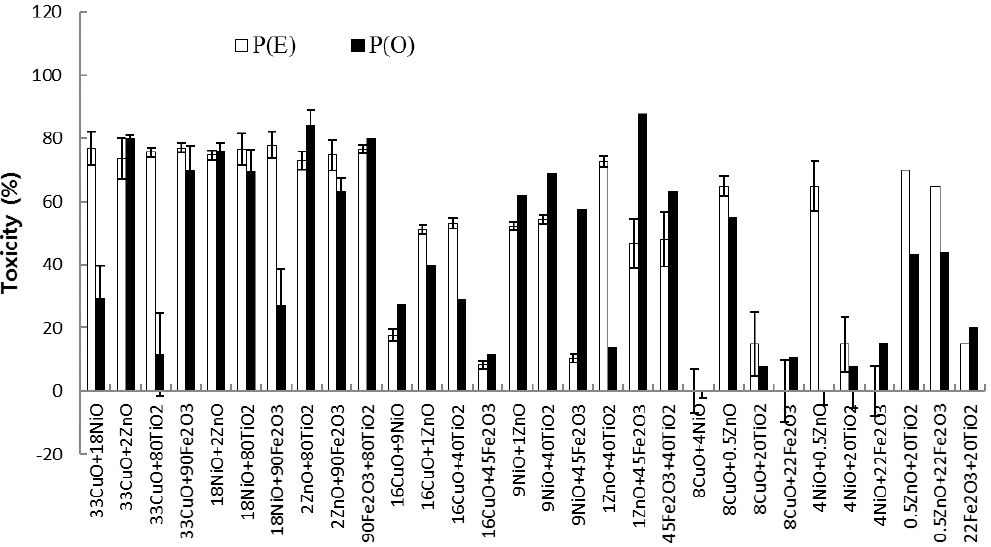
Figure 3. Summary of the observed and expected toxic effects of binary mixtures of NPs based on the chlorophyll contents of algal growth after a 72-h exposure. The term “18NiO + 2ZnO” indicates the final concentrations in the binary mixture, i.e., 18 mg/L NiO and 2 mg/L ZnO.